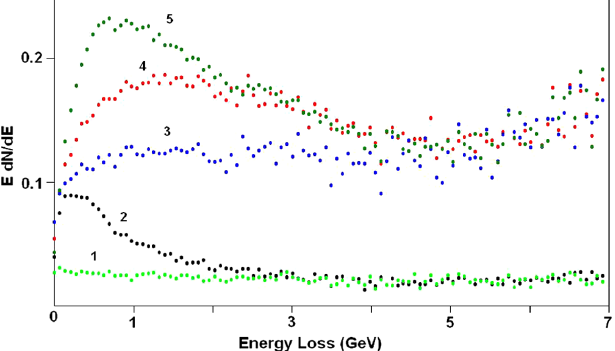
FIG. 2. The calculated energy losses: (1) in one 2.5 nonoriented strip; (2) in one strip oriented in planar orientation; (3) in nonoriented multistrip (see Fig. 1); (4) in single crystal (oriented in planar orientation) with the thickness 15 mm; (5) multistrip in planar orientation.